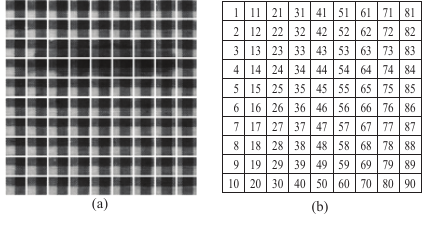
Figure 4. (a) A cropped image split into several periodic blocks; (b) Numbering sequence followed for the periodic blocks.